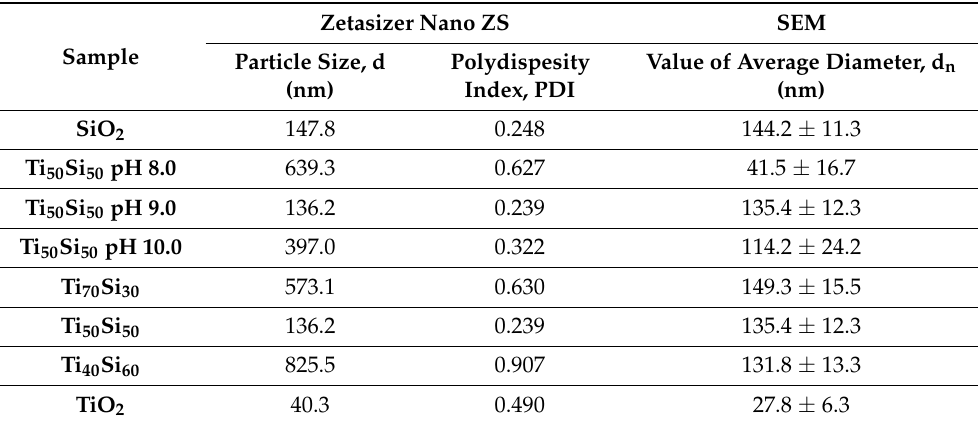
Table 5. Particle sizes of SiO 2 , TiO 2 , and Ti 50 Si 50 oxide synthesized at various pH values, and Ti x Si y oxide synthesized at pH 9.0 with different Ti/Si